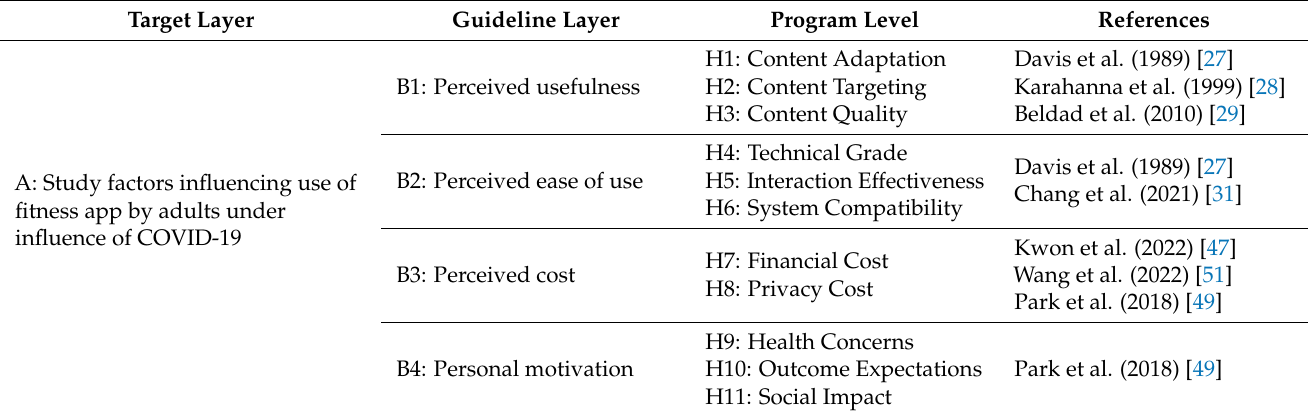
Table 1. Index system used for analyzing factors influencing use of fitness apps by adults aged 18–65 years.